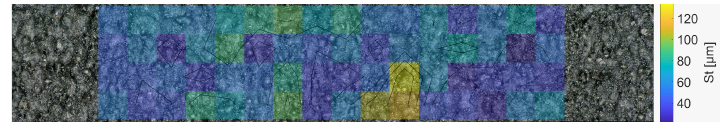
Figure 2. Exemplary surface roughness